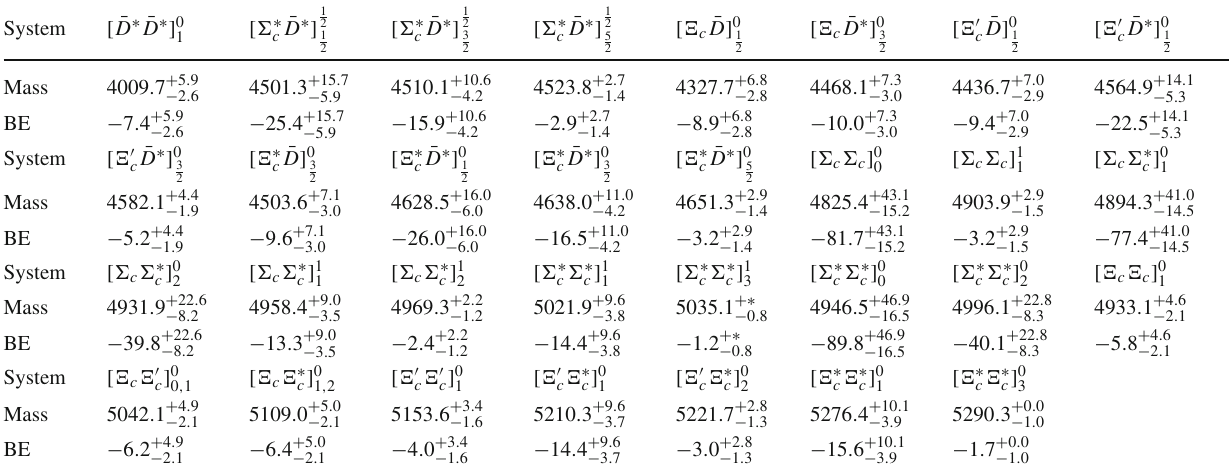
Table 4 The predicted masses and binding energies (BE) for the of our theoretical results, respectively. The “ +∗ " denotes that the charmed di-hadrons ( [ H 1 H 2 ] I ) in Table 1. We adopt the isospin aver- J aged masses for the single-charm hadrons [4]. We use the values (cid:2) = 0 . 33 and 0 . 43 GeV as inputs to give the upper and lower limits